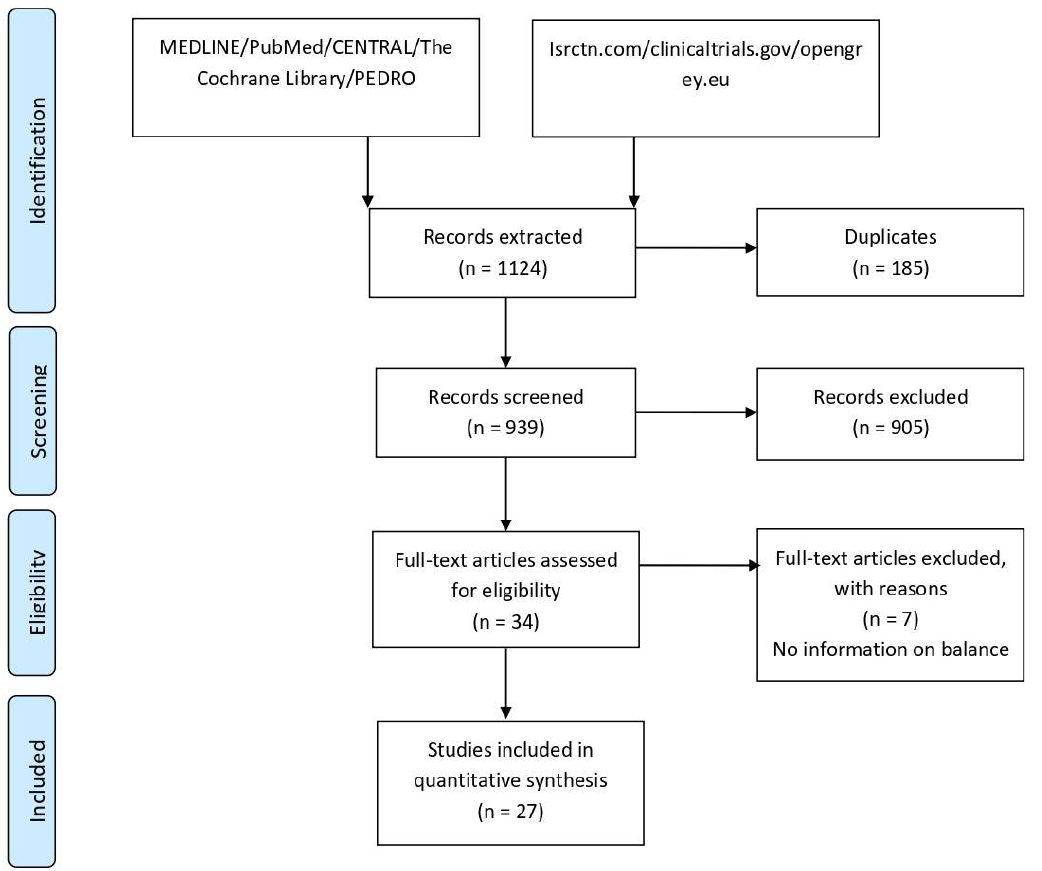
Figure 2. PRISMA of the retrieved studies.